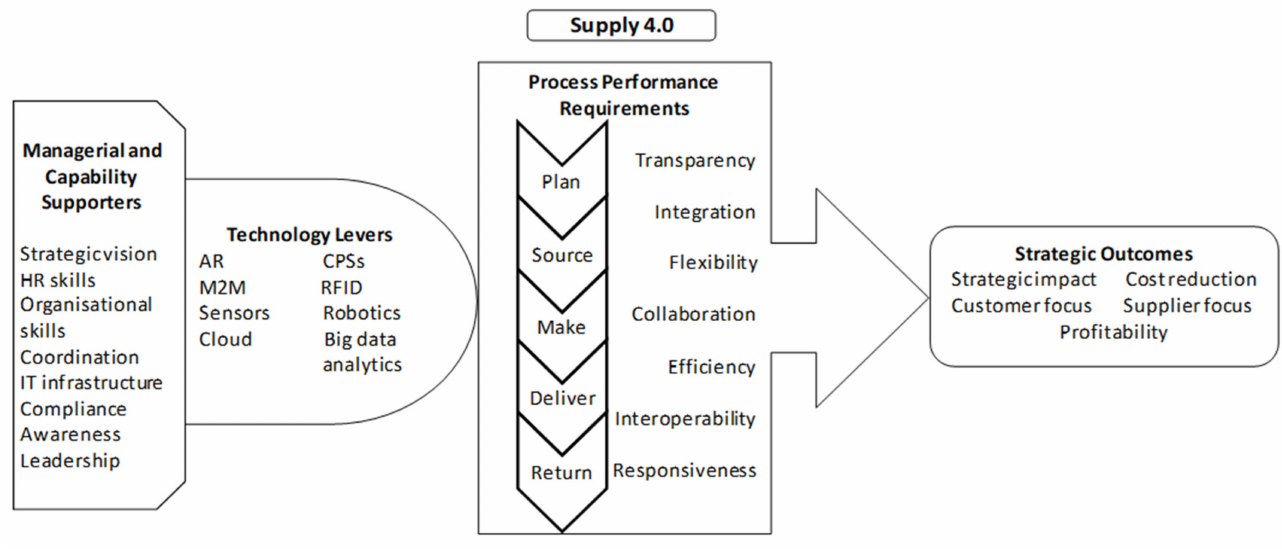
Figure 11. Theoretical framework for Supply 4.0 concept adapted from Frederico et al.